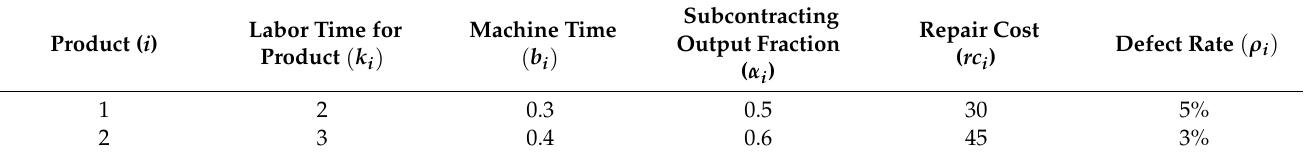
Table 2. Related Operating Data.